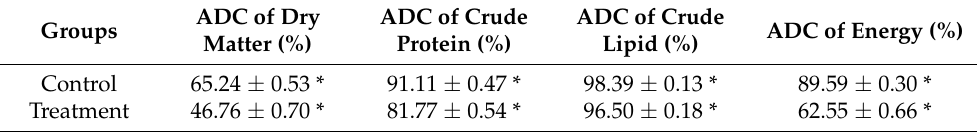
Table 6. Comparison of apparent digestibility in A. schrenckii .